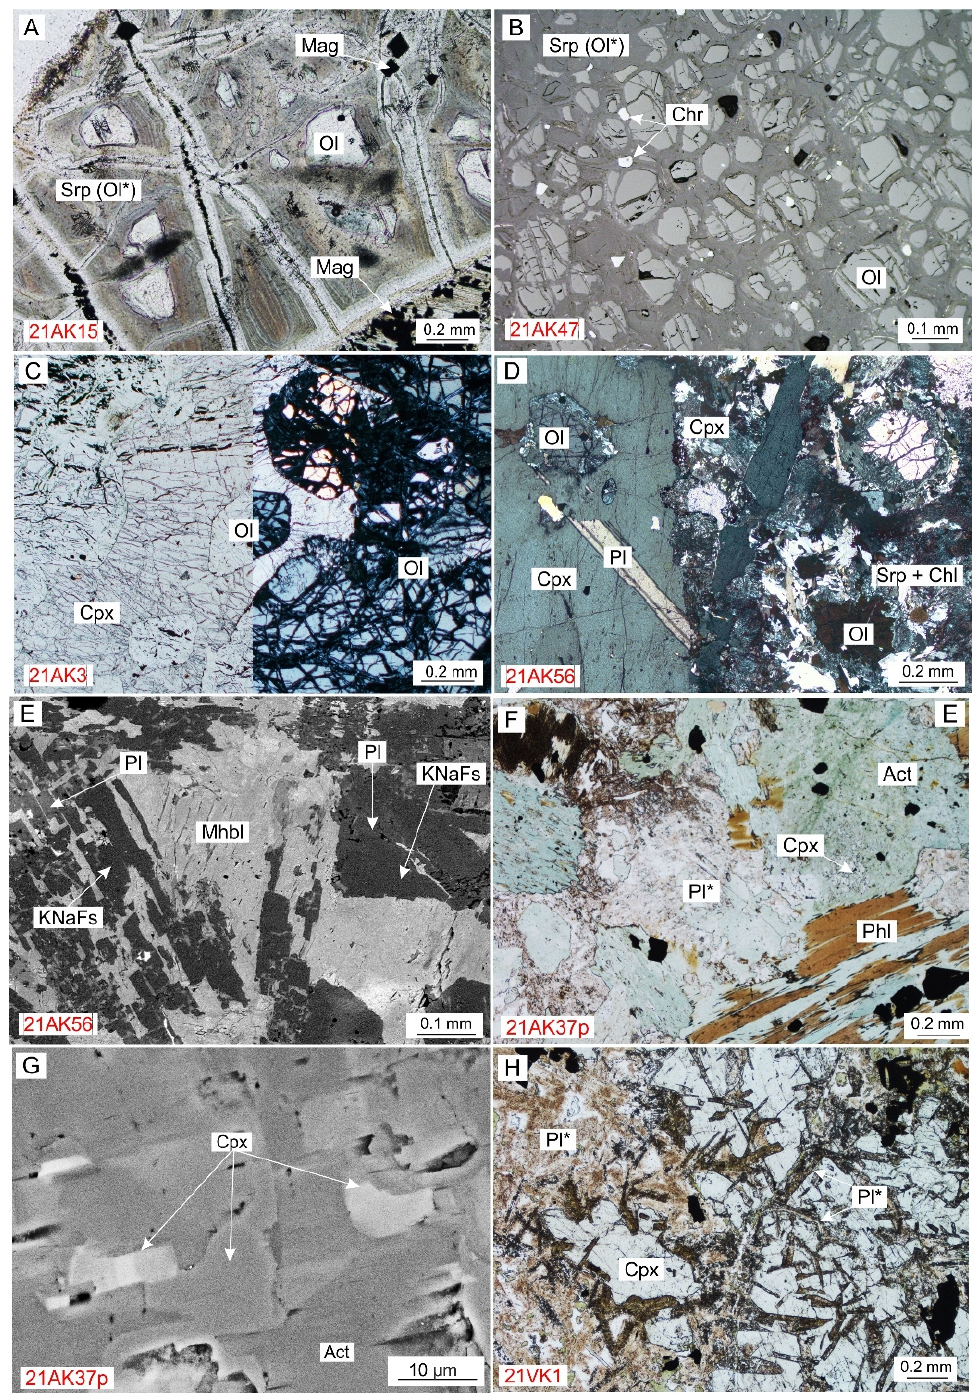
Figure 5. Petrographical features of the plutonic rocks. ( A ) serpentinized dunite (transmitted light photo); ( B ) partially serpentinized dunite, composing a xenolith in picrite (reflected light photo); ( C ) wehrlite (transmitted light photo, left side—analyzer out, right side—analyzer in); ( D ) plagio- wehrlite (transmitted light photo, analyzer in); ( E ) intergrowth of magnesiohornblende with K-Na feldspar and plagioclase in an interstice of plagiowehrlite (BSE-photo); ( F ) gabbro (monzogabbro) (transmitted light photo); ( G ) relics of clinopyroxene in actinolite pseudomorphs, monzogabbro (BSE- photo); ( H ) clinopyroxene oikocryst with plagioclase inclusions and dolerite (transmitted light